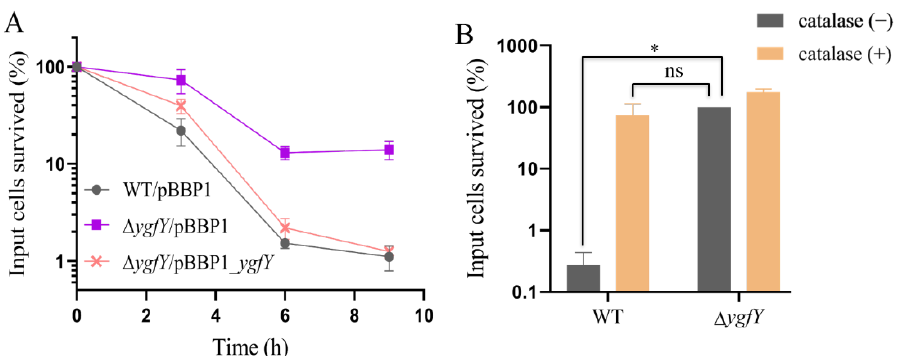
Figure 9. Survival of cells after exposed to heat shock of 42 °C. ( A ) Colony forming units (CFU) of cultures grown on LB plates. ( B ) CFU of cultures incubated in 42 °C for 6 h and then cultured on LB plates with or without catalase overlayed. Error bars indicate standard deviations of results from three biological replicates. Percentage of survived cells are normalized by CFU in cultures before heat exposure (0 h). Asterisk indicates significant difference and ns indicates no significant difference.